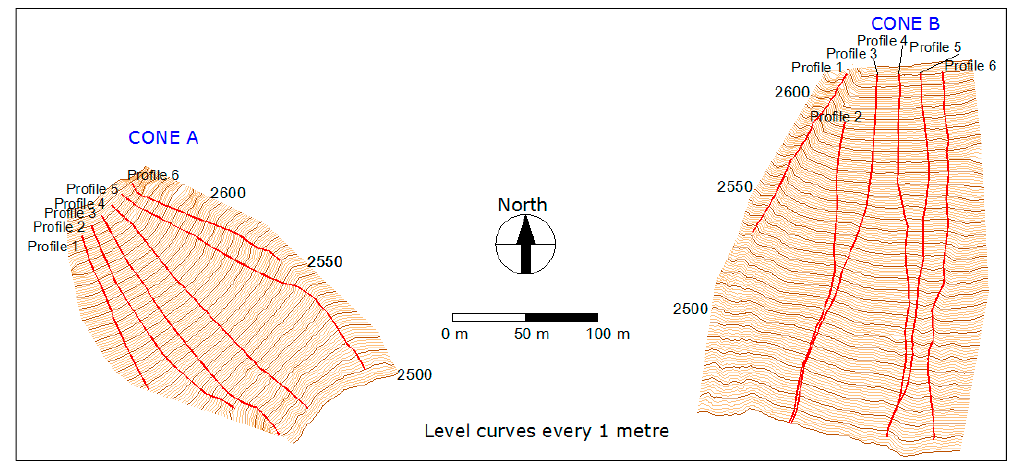
Figure 3. Debris cones (A and B) and the representation of the maximum slope profiles over the DEM of 2009.